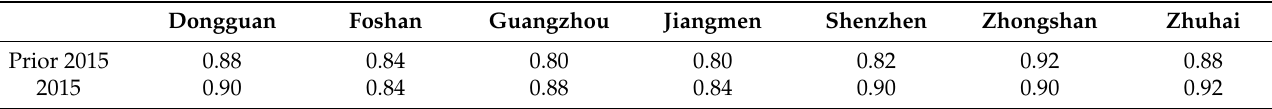
Table 3. Summary of accuracy assessment for classification results using the Kappa coefficient.